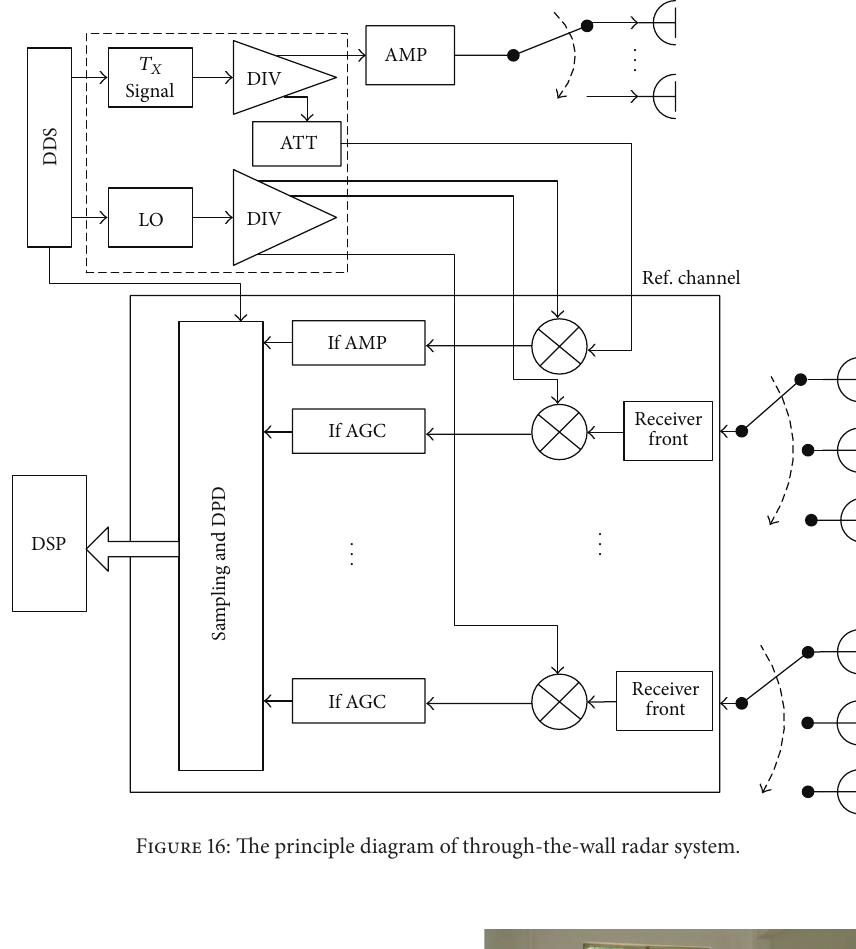
Figure 16: The principle diagram of through-the-wall radar system.